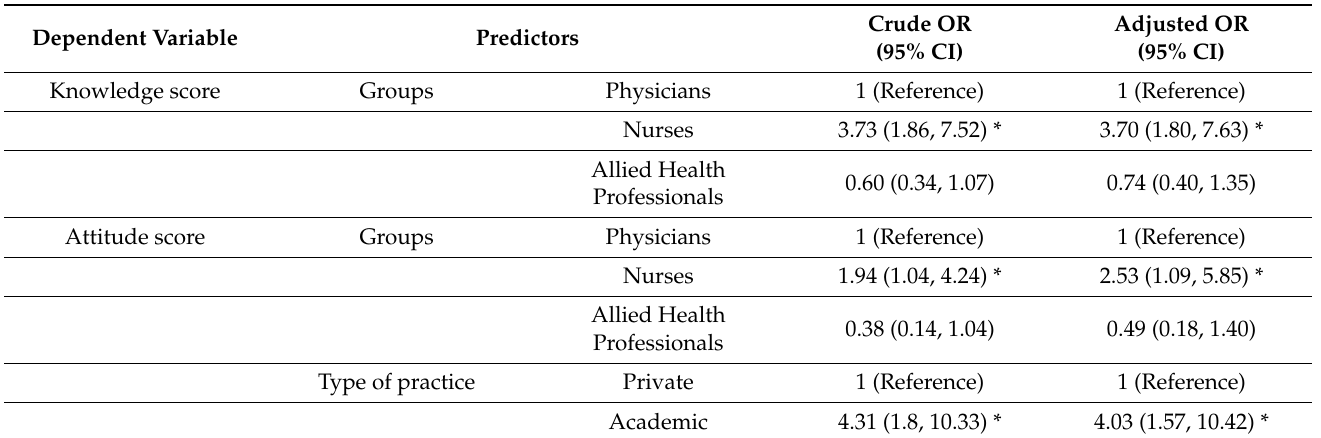
Table 9. Predictors of good knowledge scores and attitude scores using binary logistic